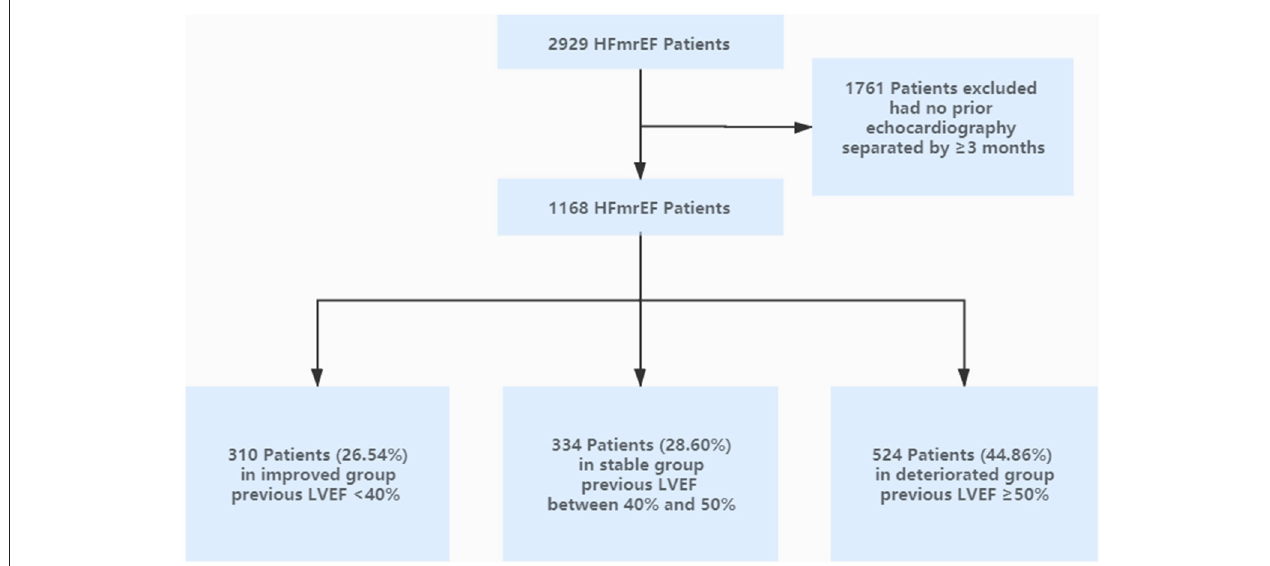
FIGURE 1 | Flow diagram of patient